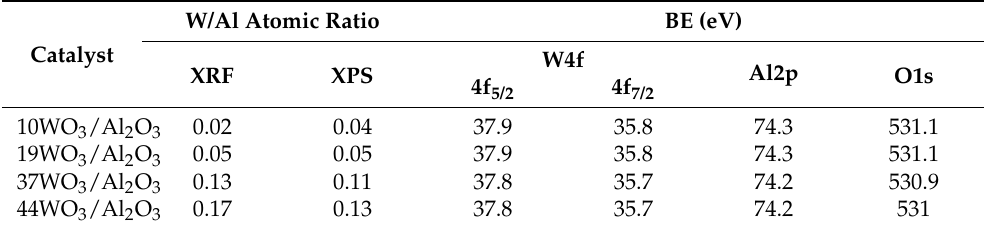
Table 2. Bulk and surface compositions determined via XRF and XPS measurements, respectively, expressed as the atomic ratio of W/Al and the binding energy values of W4f, Al2p and O1s peaks of WO 3 /Al 2 O 3